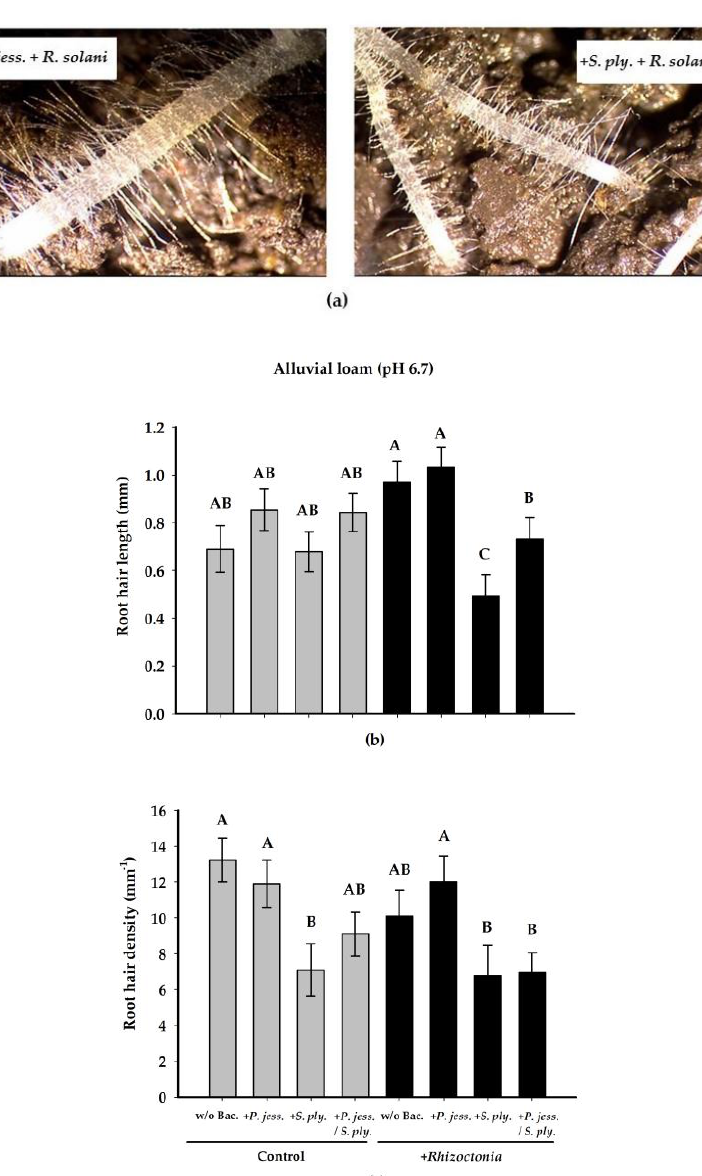
Figure 3. Root hair development ( a ), root hair length (mm) ( b ) and root hair density (mm − 1 ) ( c ) of Lactuca sativa L. cv. Tizian. The plants were grown on alluvial loam without bacterial inoculation (w/o Bac.), pre-inoculated with Pseudomonas jessenii RU47 ( +P. jess. ), Serratia plymuthica 3Re-4-18 ( +S. ply. ), a combination of both ( +P. jess / S. ply. ), with and without (Control) subsequent inoculation with Rhizoctonia solani AG1-IB (+ Rhizoctonia ). Means ± standard errors of four independent replicates. Different characters indicate significant differences (one-way ANOVA, Holm-Sidak test, p = 0.05).